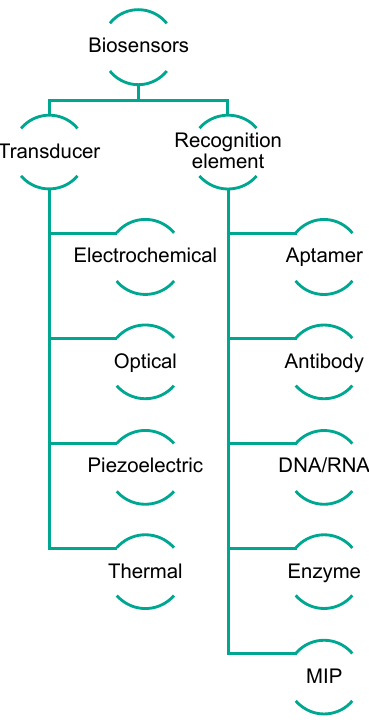
Figure 3. Schematic representation of biosensor classification.